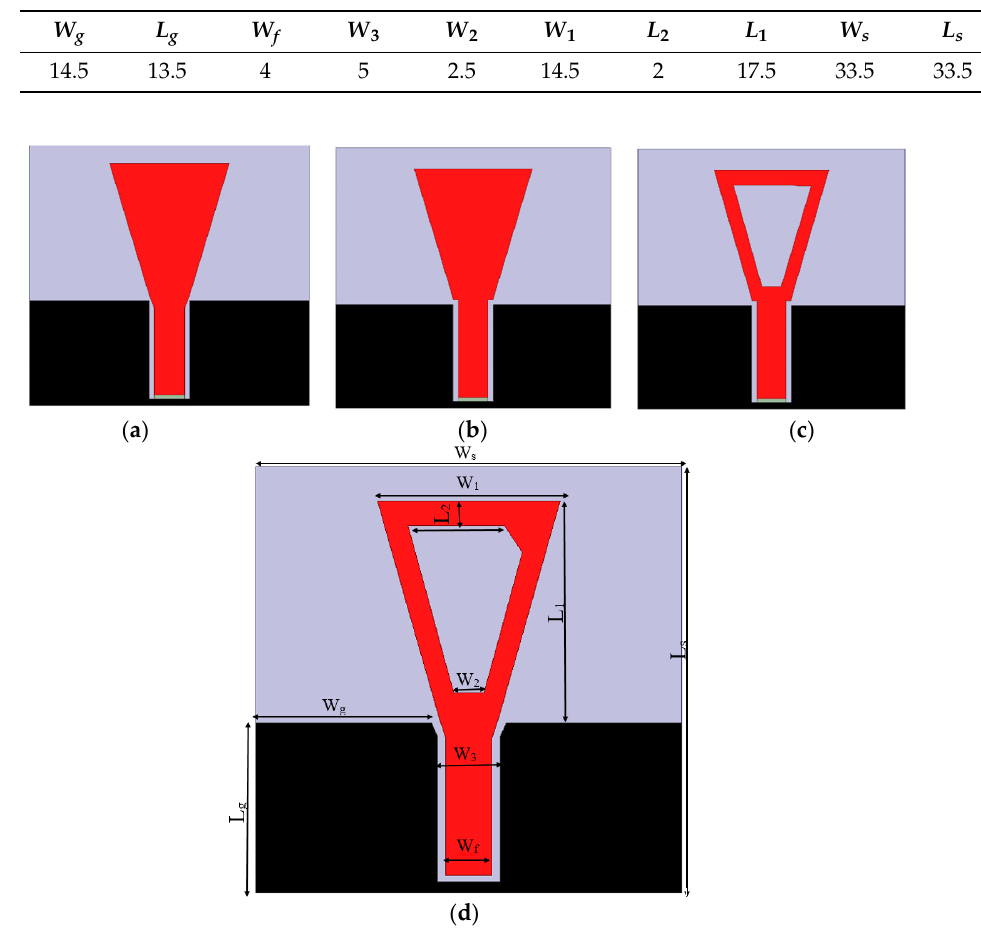
Figure 3. The design steps of CPW-CP monopole antenna, ( a ) trapezoidal monopole and ( b ) trapezoidal monopole with notches, ( c ) trapezoidal monopole after etching trapezoidal slot and ( d ) Configuration of the circularly polarized CPW-monopole